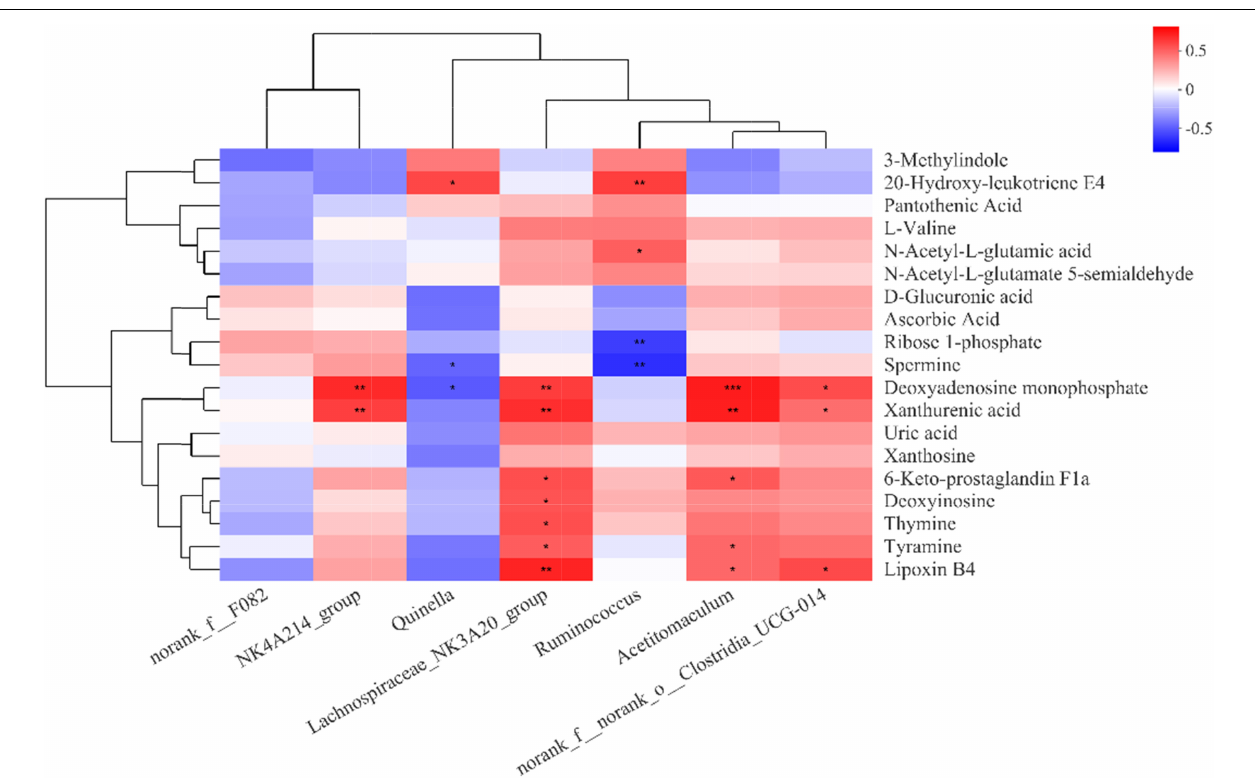
FIGURE 6 | Correlation matrix between rumen bacterial genera and rumen differential metabolites (derived from Table 2 ). Each column in the graph represents a genus, each row represents a metabolite, and each cell represents a Pearson correlation coefficient between a genus and a metabolite. Red denotes positive correlation and blue denotes negative correlation. *0.01 < P ≤ 0.05; **0.001 < P ≤ 0.01; *** P ≤ 0.001.